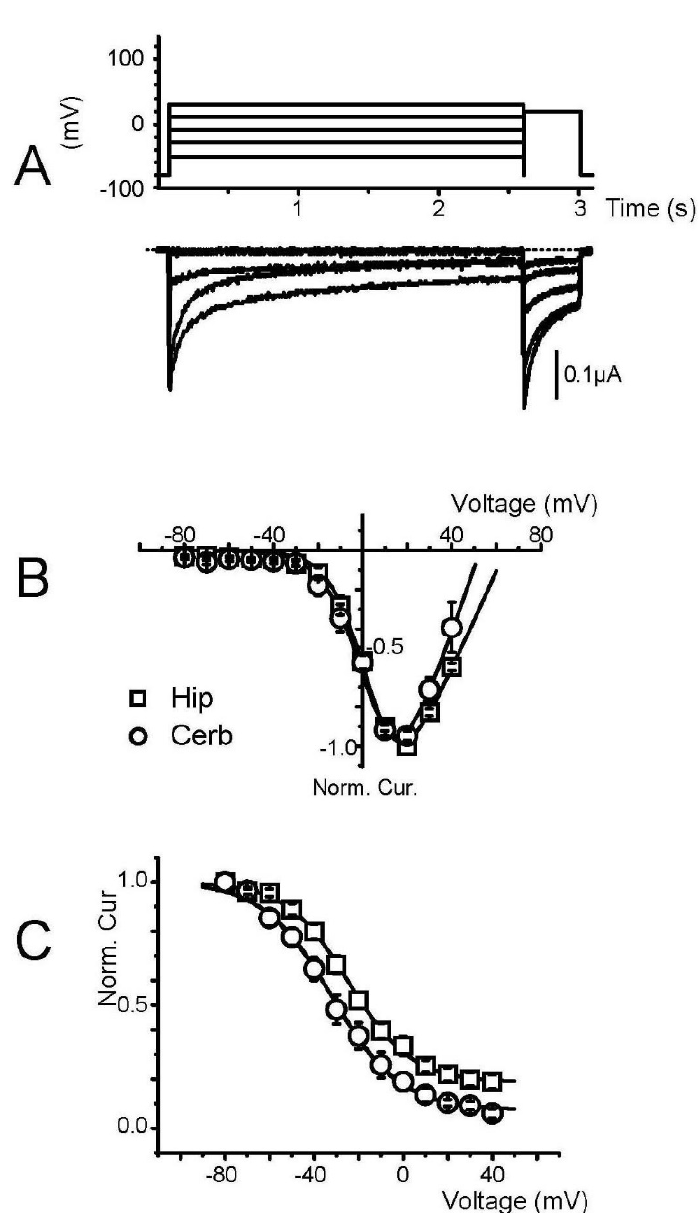
Figure 3. Biophysical properties of expressed voltage-gated Ca 2+ channels. ( A ) Typical current traces recorded from an oocyte one day after injection of a hippocampal membrane preparation (7 mg/mL) during a twostep protocol. The first conditioning step had a duration of 2.5 s, and an amplitude varying from − 80 to +40 mV in 10 mV increments, while the second step had a duration of 400 ms and remained at the same value ( +10 mV). Only some steps are displayed here. ( B ) Current–voltage curves obtained from similar protocols by plotting the relative peak current amplitude recorded during the first step as a function of the voltage of this step. These curves were obtained on oocytes injected with either hippocampal (Hip) or cerebellum (Cerb) membrane preparations, and Vact, kact, and Erev were 4.7 ± 0.4 mV; 7.7 ± 0.3 mV, 67 ± 1 mV ( n = 8), and 6.8 ± 1.3 mV; and 8.4 ± 0.5 mV and 54 ± 2 mV ( n = 11) for hippocampal and cerebellar membranes, respectively. ( C ) Isochronal inactivation curves obtained by plotting the relative peak current amplitude recorded during the second step as a function of the voltage of the first step. These curves were obtained on oocytes injected either with hippocampal (Hip) or cerebellum (Cerb) membrane preparations, and Vin, kin, and Rin were − 25 ± 3 mV; 13 ± 1 mV, 0.1 ± 0.02 ( n = 5), and − 31 ± 4 mV; 15 ± 1 mV and 0.2 ± 0.01 ( n = 10) for hippocampal and cerebellar membranes, respectively.